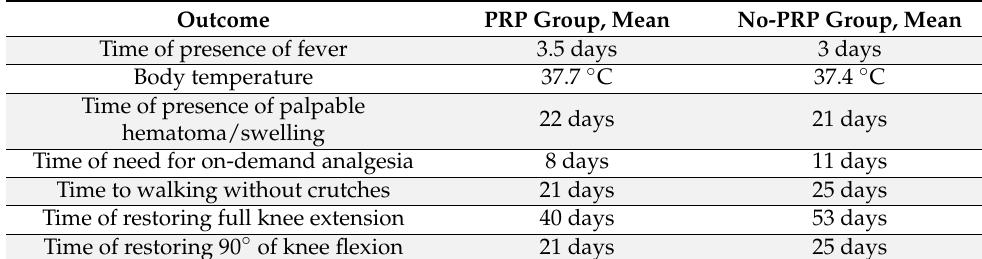
Table 1. Early postoperative outcomes.